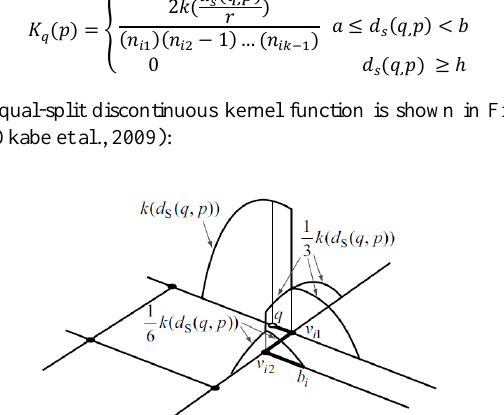
Figure 4. Equal-split discontinuous kernel function (Okabe et al., 2009)